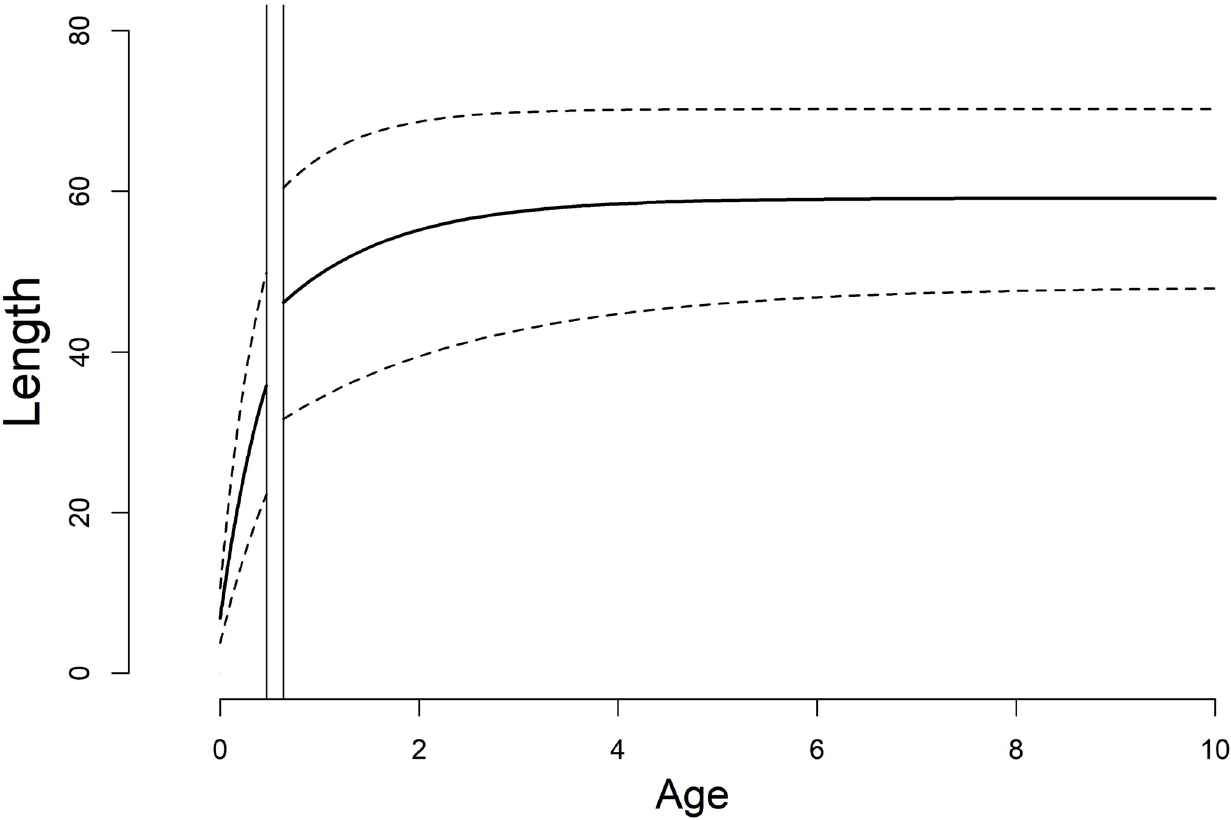
Fig 4. Growth curve. Predicted growth of reticulated flatwoods salamanders across both larval and adult stages. The two vertical lines represent the 95% credible intervals for minimum and maximum age at metamorphosis respectively, and the dashed lines represent 95% posterior predictive intervals. Length is snout-vent length (SVL) in